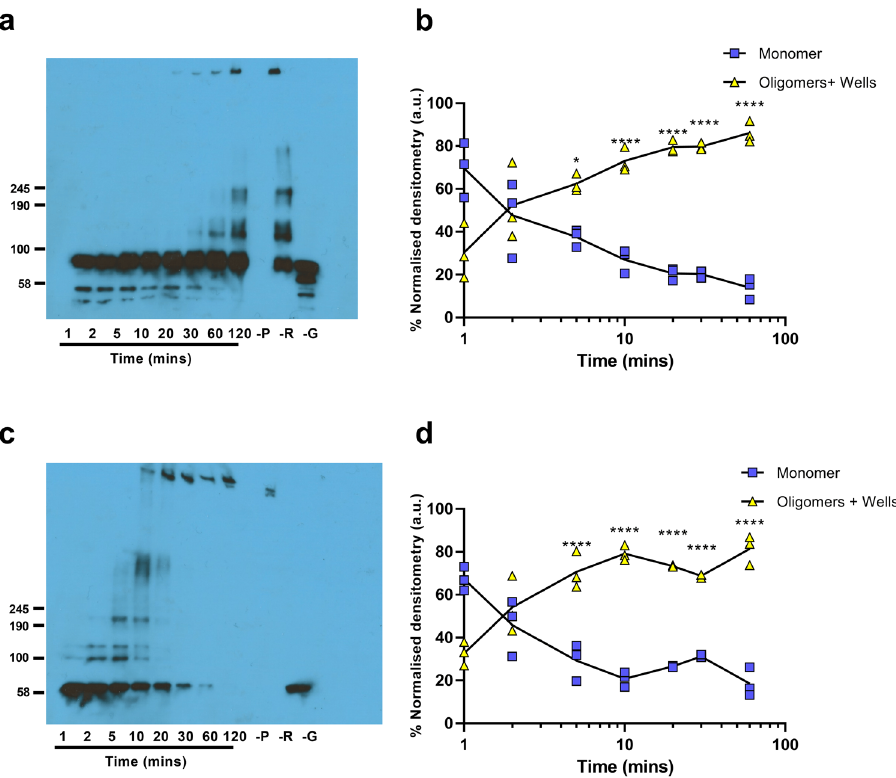
Fig. 3 Elongation of protein monomers into higher-order oligomers. Polymerase activity assay in the presence of glutaraldehyde, showing the formation of higher-order oligomers by representative Western blot of a polymerase activity assay of a 3D pol -WT and c 3D pol -GNN, b and d . Quanti fi cation of 3D pol higher-order oligomer formation of 3D pol -WT and 3D pol -GNN, respectively, over time by densitometry. Control reactions were included without primer (-P), without RNA template (-R), or without glutaraldehyde (-G) and analysed after 120 min. Values normalised to the average densitometry values (a.u) at each timepoint across three biological repeats using ImageJ. Approximate molecular weights are indicated, by comparison to Coomassie-stained gels. Comparisons between timepoints are within 3D pol -WT and 3D pol -GNN respectively ( n = 3, ± SEM, analysed by two-way ANOVA, * p < 0.05, ** p <